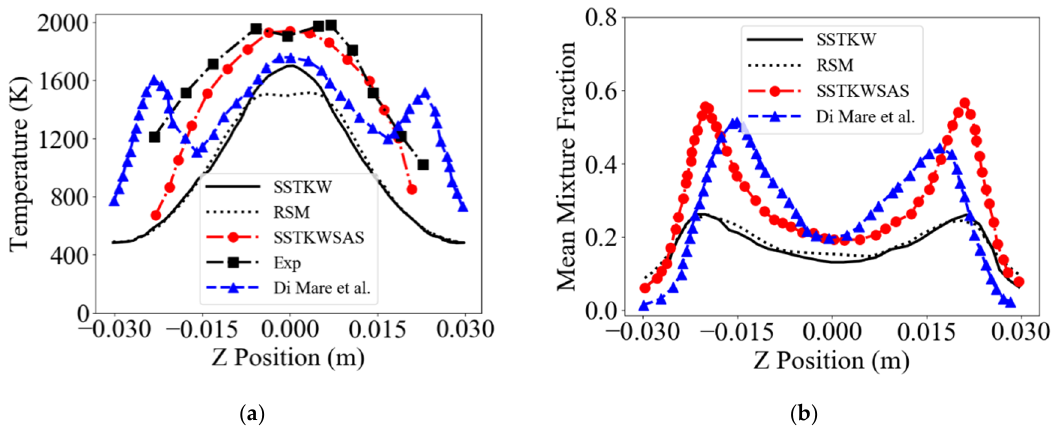
Figure 5. Profiles of time-averaged temperature and mixture fraction on the horizontal midplane of the combustor (at x = 20 mm). ( a ) Temperature Profiles, ( b ) Mixture fraction Profiles.